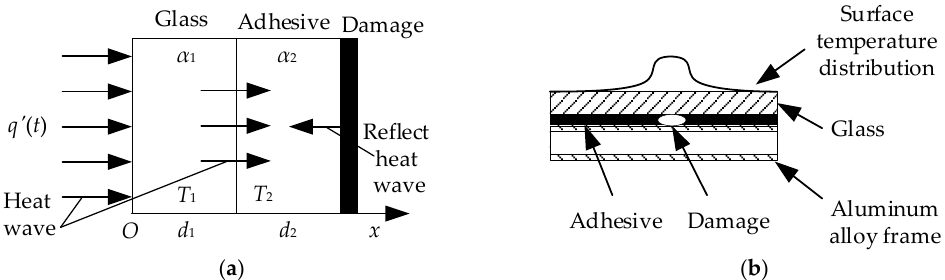
Figure 2. Thermal wave propagation and temperature distribution of damaged bonded structure. ( a ) Heat wave propagation in damaged bonded structure; ( b ) temperature distribution of damaged bonded structure.